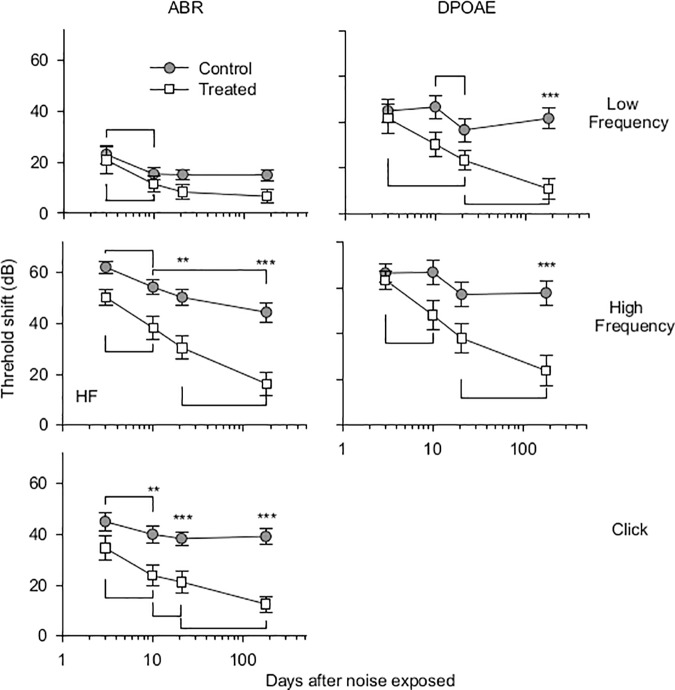
Time course of in-group ABR and DPOAE threshold shifts.The mean and SEM (vertical bars) for “click” (CLK), low frequency (LF), 0.5 and 2 kHz; and high frequency (HF), 2, 4, 6, 8 kHz ABR data were plotted for each time point. Two-way ANOVA and Bonferroni Post Hoc test were applied. The symbols of ** and*** indicate significant differences of p < 0.01and 0.001, respectively. Horizontal bars indicate significant differences of p < 0.05. Both the ABR and DPOAE threshold shifts of the HPN-07-treated group was significantly less than the untreated group at all recording intervals.